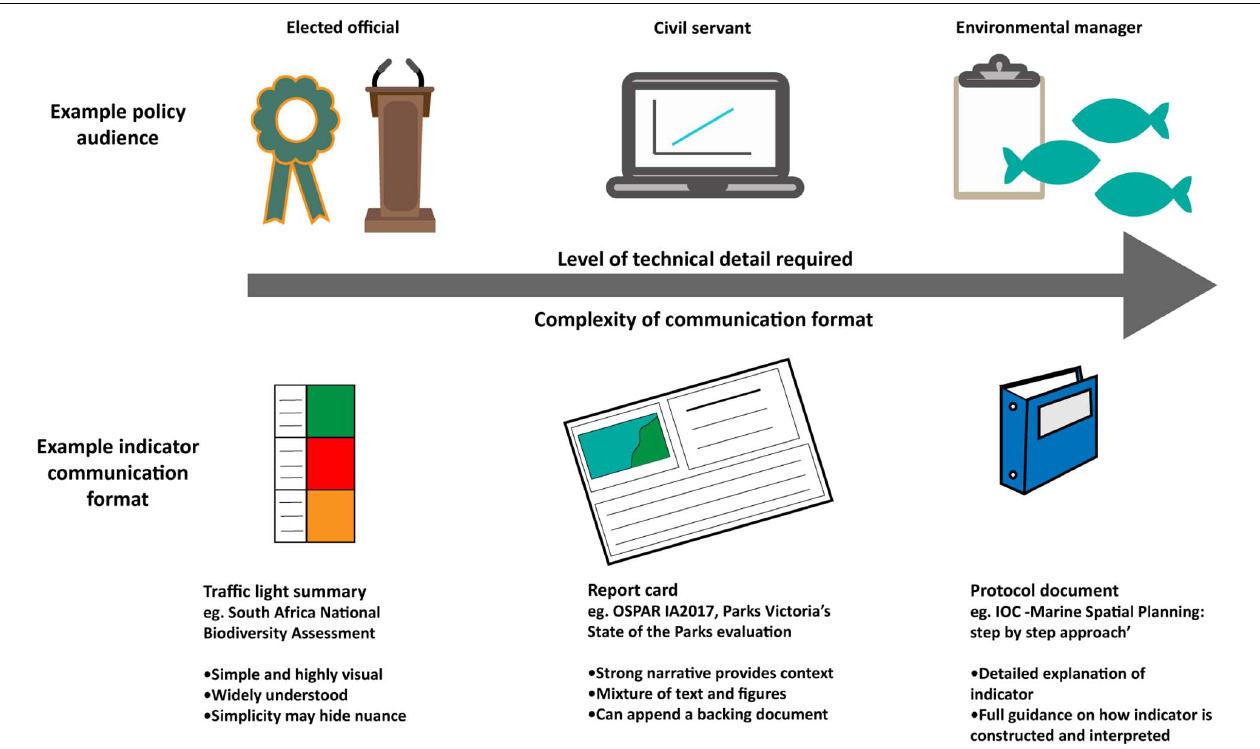
FIGURE 3 | Indicator communication formats should vary in level of technical detail depending on the policy audience.